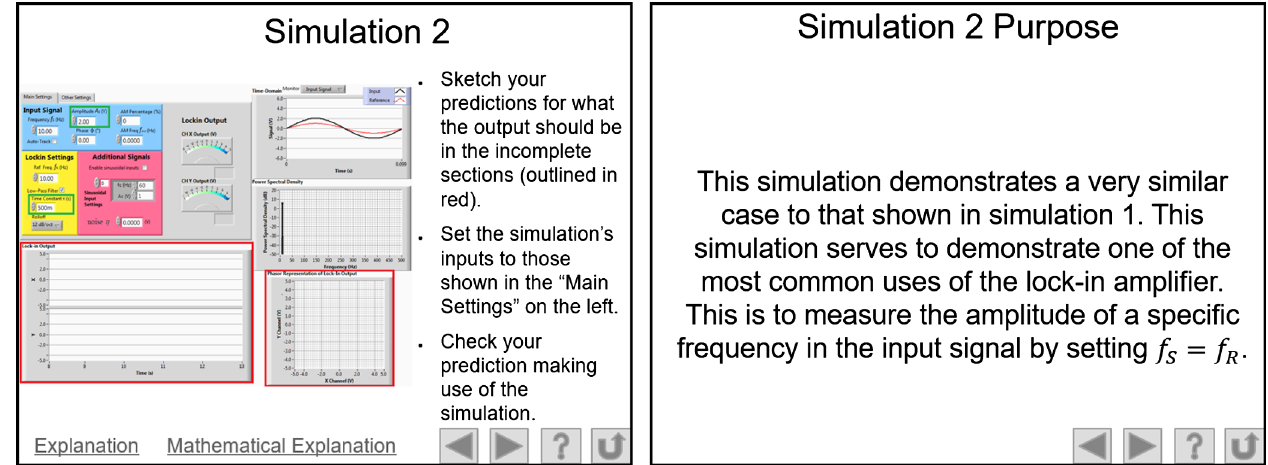
FIG. 1. Example of a typical simulation question (left) and the associated “ purpose ” slide (right). For the simulation question, red bounding boxes indicate information that the student is expected to sketch or provide, consistent with the lock-in settings and/or output and green bounding boxes highlight settings that were changed from a prior simulation